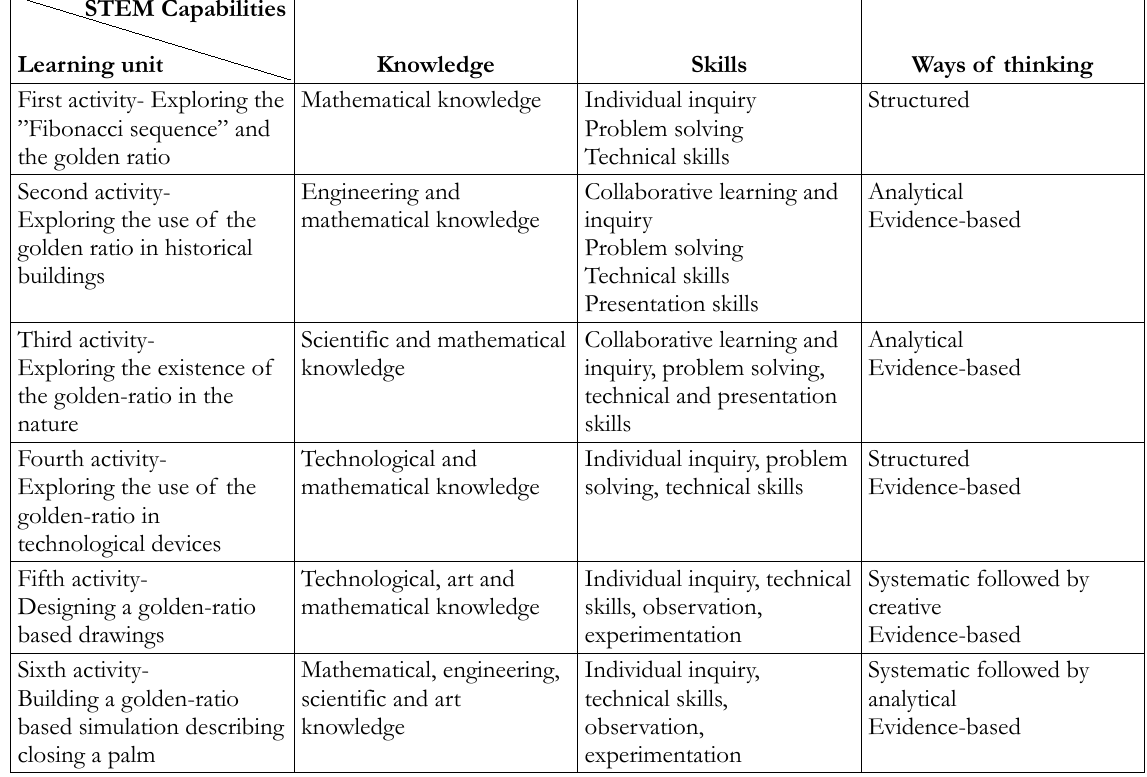
Table 2. The “Fibonacci sequence” activities